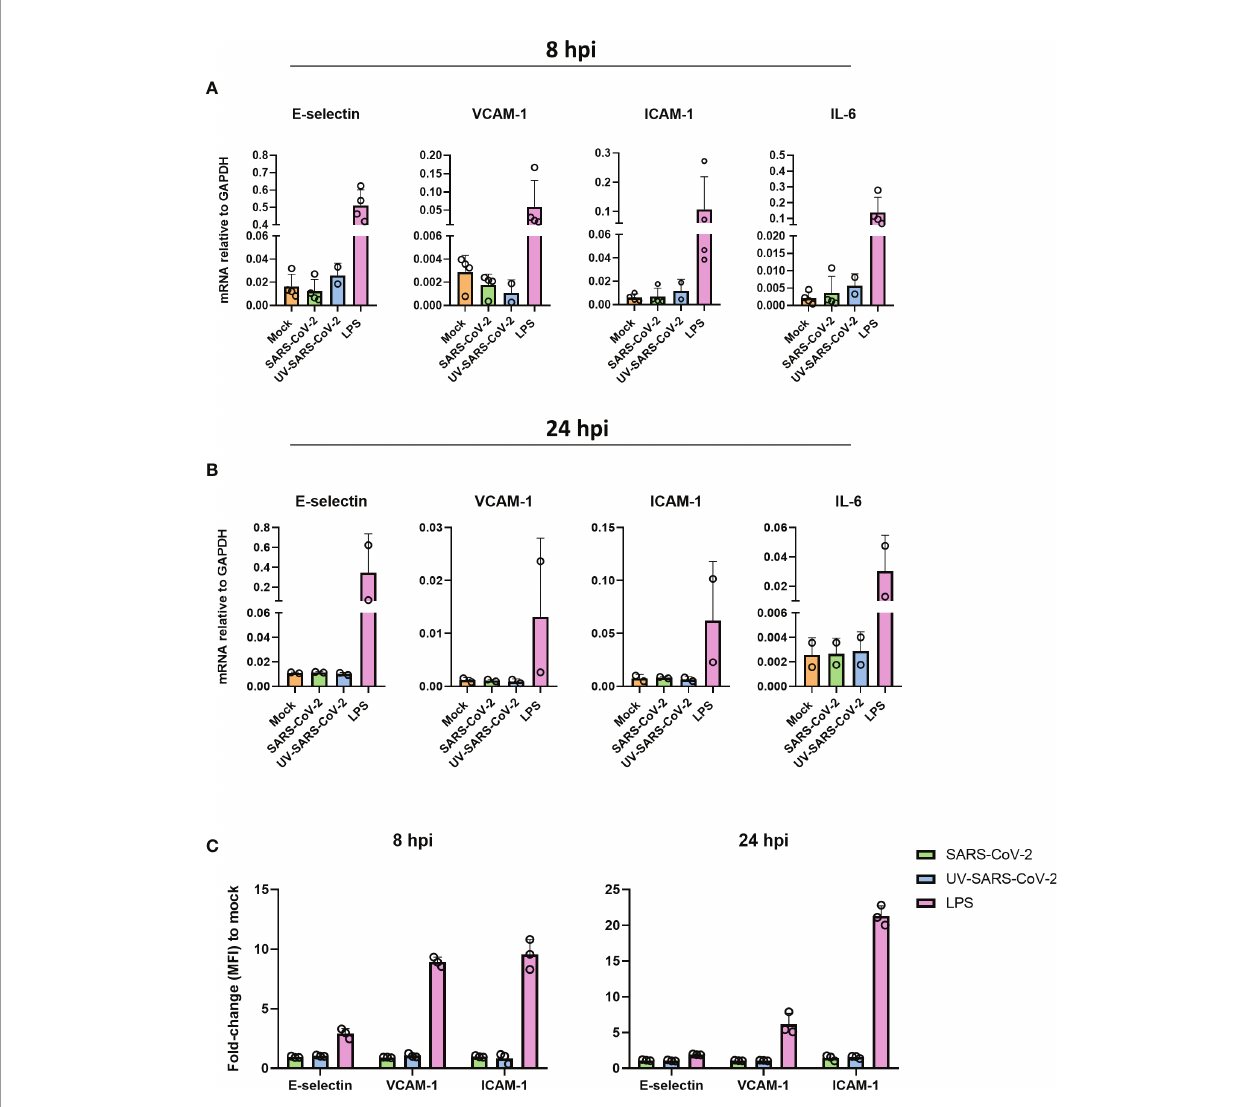
FIGURE 2 | SARS-CoV-2 does not activate HLMVEC. (A, B) HLMVEC were inoculated with SARS-CoV-2 at MOI 5 or LPS 1 µg/mL for 8 or 24 hr. The mRNA levels of E-selectin, VCAM-1, ICAM-1, and IL-6 at 8 (A) and 24 hpi (B) were obtained by qPCR. Results are expressed as the mean ± SD of 2-4 individual experiments with duplicate technical replicates (C) Protein expression of E-selectin, VCAM-1 and ICAM-1 at 8 and 24 hpi by fl owcytometry, data is represented as MFI fold change to mock and represented as the mean ± SD of at least three independent experiments. Each symbol represents data from a single independent experiment. Gene expression values were normalized to the expression of the housekeeping gene GAPDH. Student T tests were used to evaluate statistical differences and a p value ≤ 0.05 was considered signi fi cant with *p ≤ 0.05, **p ≤ 0.01 and ***p ≤ 0.001. In the absence of ‘ * ’ the data is non-signi fi